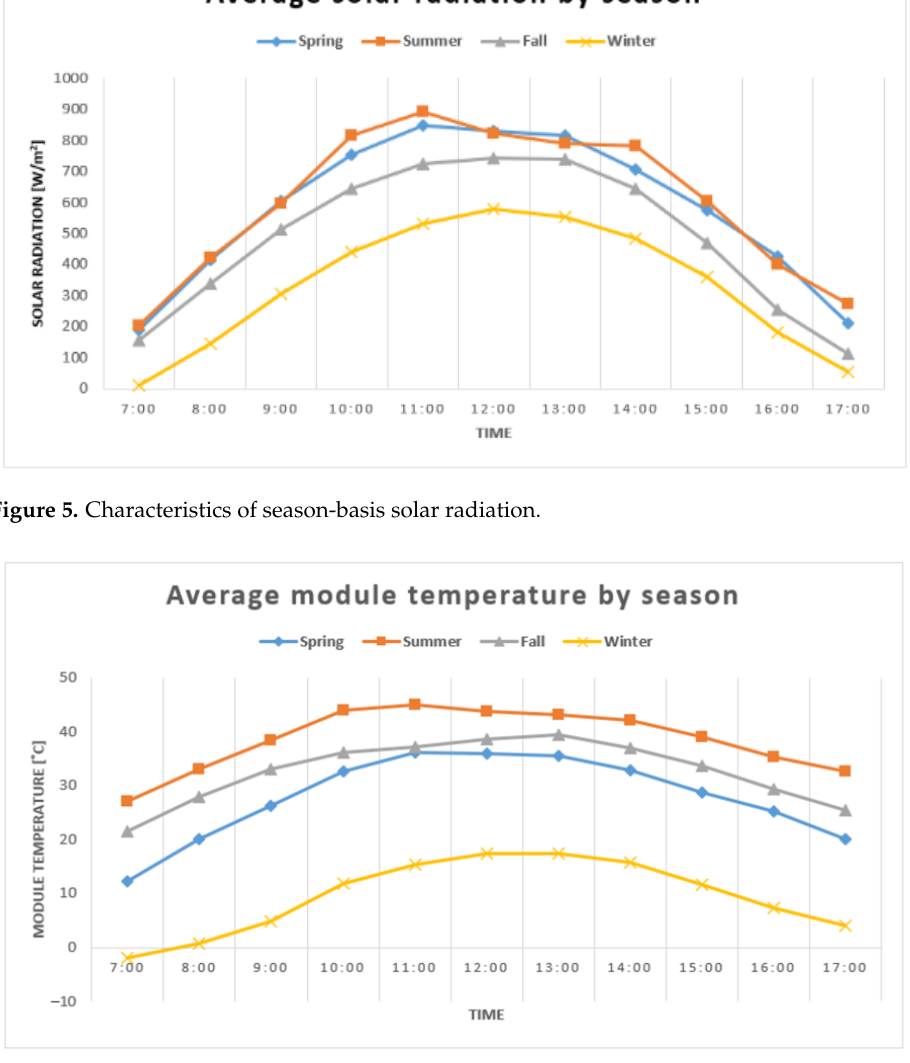
Figure 6. Characteristics of season-basis temperature.